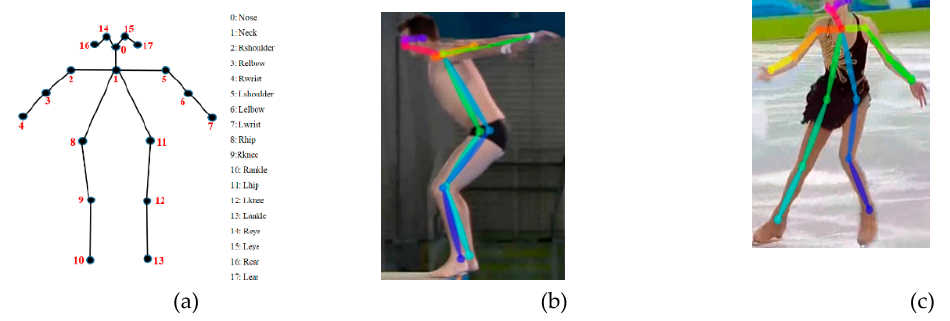
Figure 2. The 18-key point skeleton model and detection examples of OpenPose [21]. ( a ) Skeleton model of 18 joints, ( b ) example of diving, and ( c ) example of figure skating.